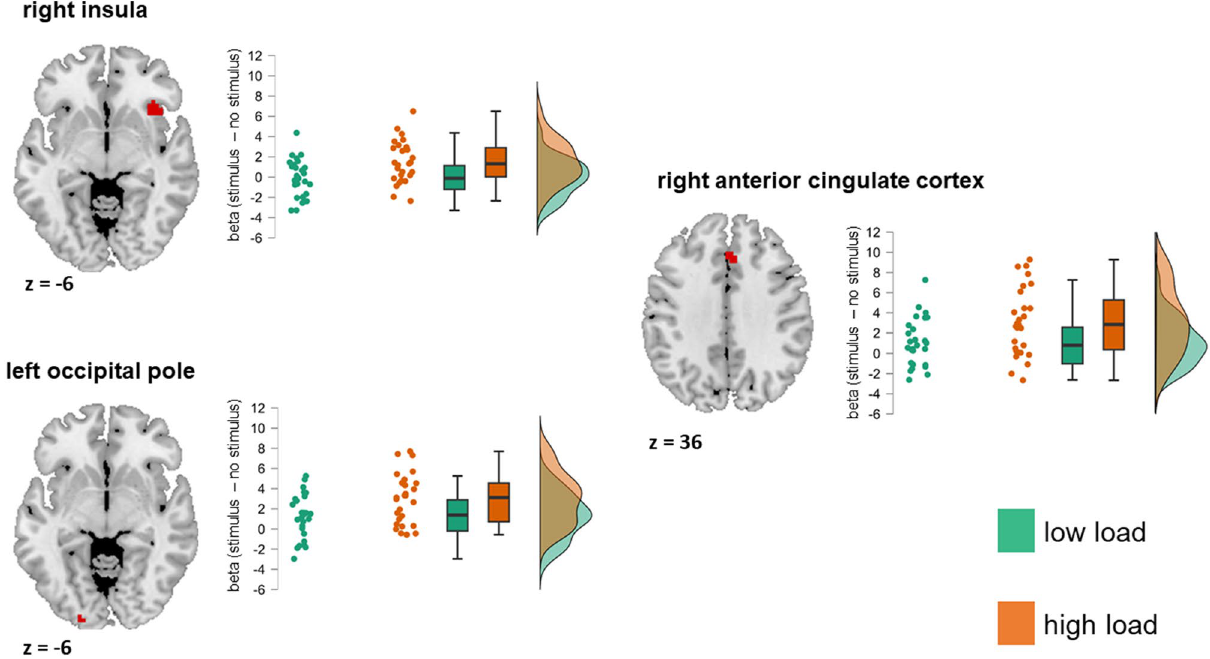
Figure 3. Clusters of increased activity in the load contrast during target processing in the task-difficulty ROIs and visual areas for N = 27 participants. In the task-difficulty ROIs, increased activation was found under high load in the right insula (peak t -value = 5.40, p < 0.05) and the right anterior cingulate cortex (peak t -value = 4.09, p < 0.05). In visual areas, one cluster of increased activity under high load was observed in the left occipital pole (peak t -value = 4.23, p < 0.05). Displays of the clusters are accompanied by raincloud plots of the individual data points in each condition, comprising a jittered scatter plot of the cluster average of the betas per subject, a box- and-whisker plot, and a violin plot of the same